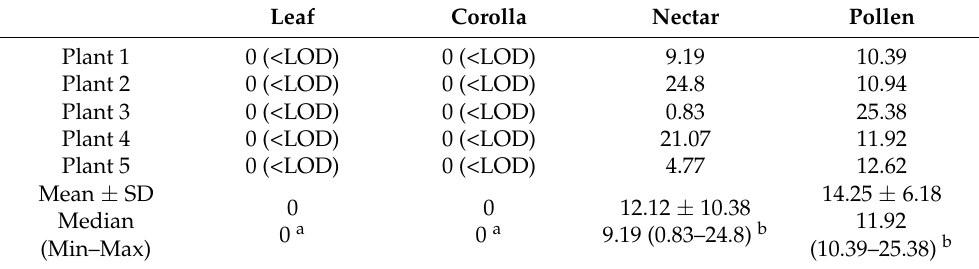
Table 1. Total phenolamide content in sunflower tissues expressed as mg triferuloyl spermidine equivalent (TSE)/g tissue. Superscript letters indicate the outputs of the Kruskal–Wallis test between tissues ( p < 0.001), with two medians sharing a letter being not significantly different. LOD: limit of detection of N,N (cid:48) ,N (cid:48)(cid:48) -triferuloyl spermidine in a Waters™ Q-ToF US: 2.5 × 10 − 6